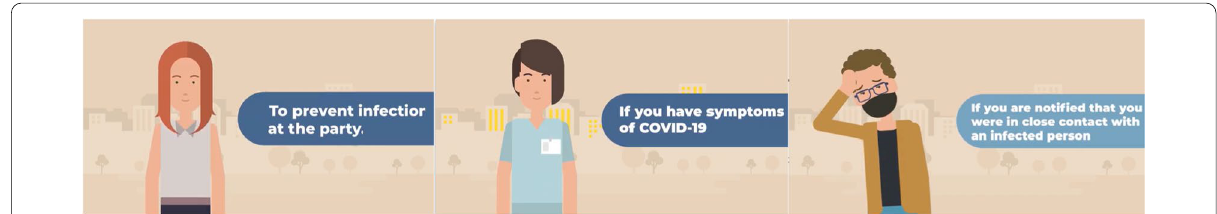
Fig. 1 YouTube videos created by our group (MINNA) (Left: to prevent infections at a gathering, Center: if you have symptoms of COVID-19, and Right: if you are notified that you were in close contact with an infected person)